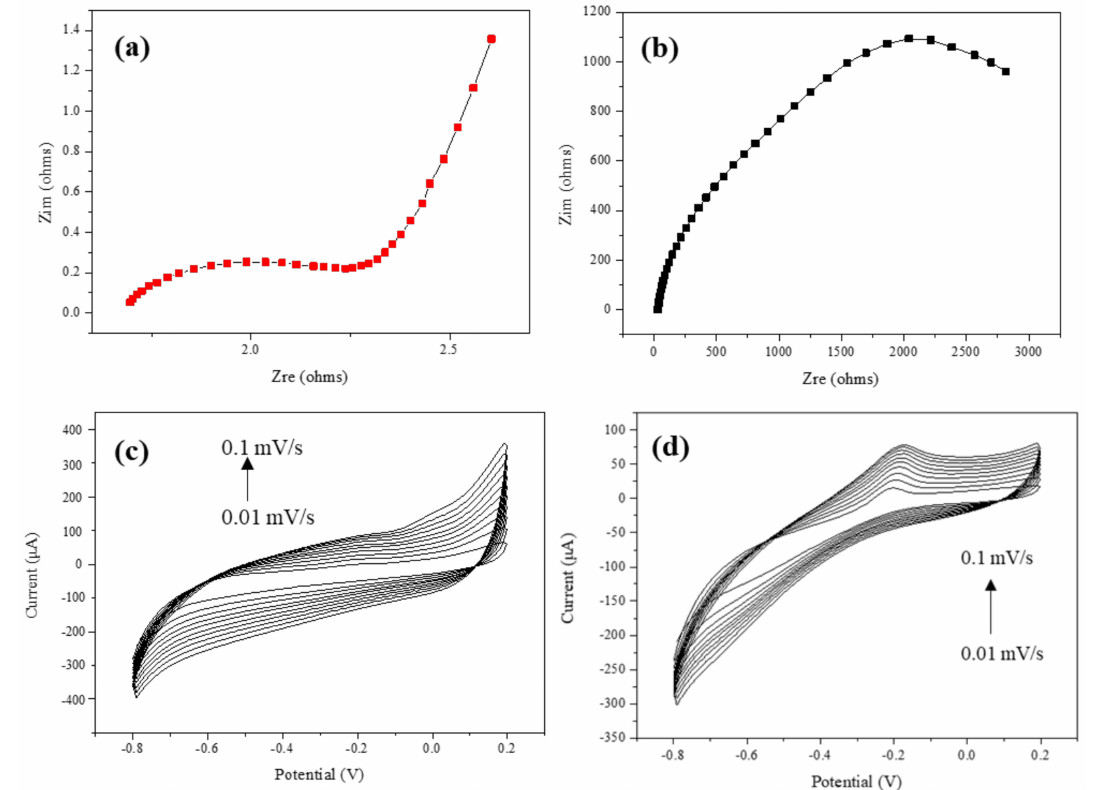
Figure 3. Electrochemical properties of the developed GO/Co/chitosan-based nano-biosensor. EIS measurement of the ( a ) GO/Co/chitosan electrode; ( b ) bare electrode. Cyclic voltammetry mea- surement following the use of D-glucose for glucose oxidase immobilization onto the modified Au electrode: ( c ) 1st day; ( d ) 14th